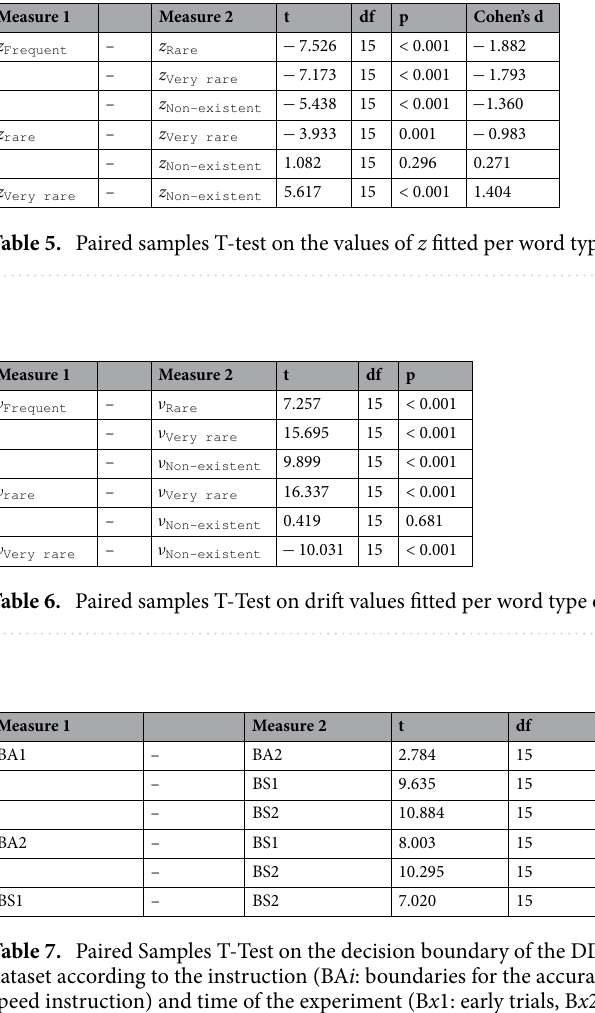
Table 7. Paired Samples T-Test on the decision boundary of the DDM, fitted on the lexical classification dataset according to the instruction (BA i : boundaries for the accuracy instruction, BS i : boundaries for the speed instruction) and time of the experiment (B x 1: early trials, B x 2: late trials).